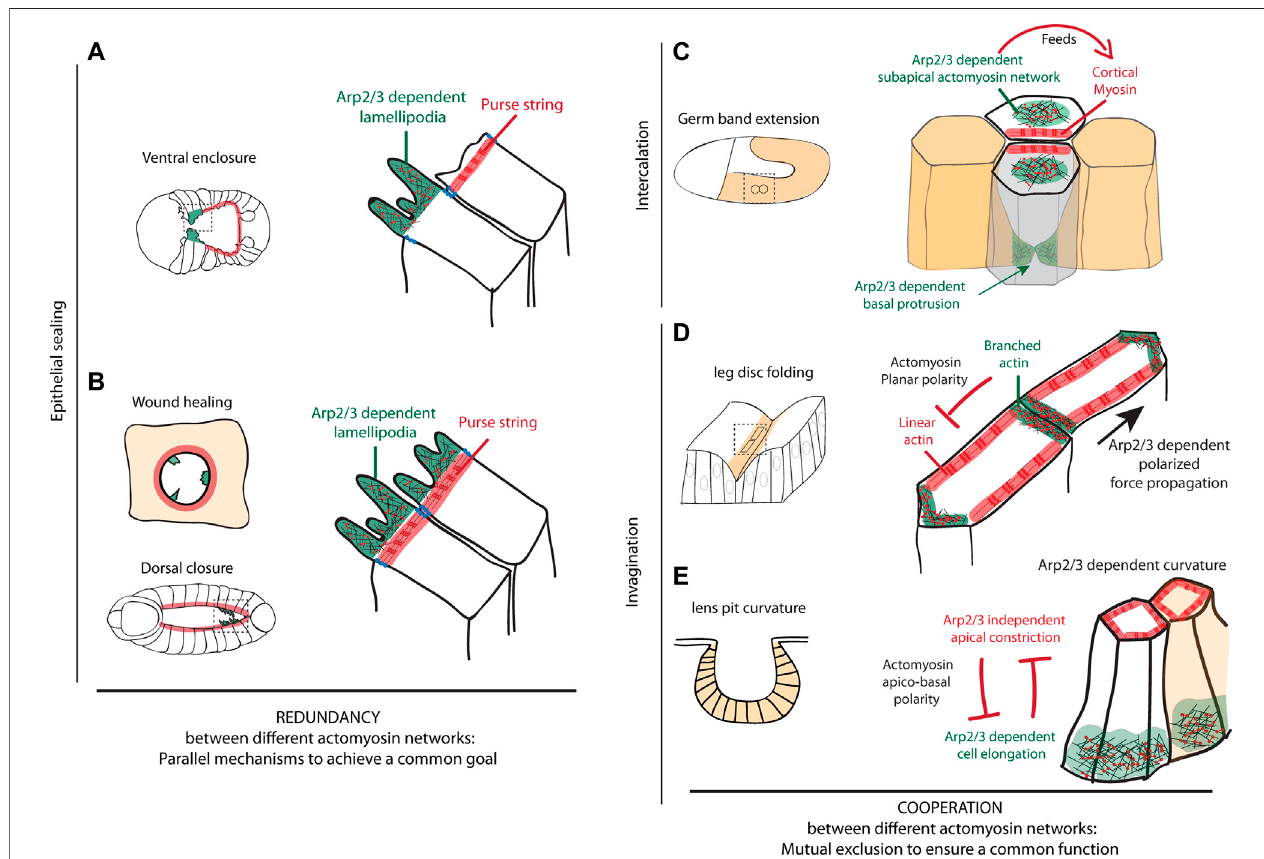
FIGURE 2 | Arp2/3 functions during morphogenetic events (A – B) Epithelial sealing mechanisms are schematized, including ventral enclosure in C. elegans (A) , epithelial wound healing and dorsal closure in Drosophila (B) . These schemes show that Arp2/3 plays an important role during epithelial sealing in the formation of lamellipodia. Theyfurtherhighlightthatbranchedandlinearactin networks actinparallel inthesedifferentmodel systemstoclose agapseparatingtwoepithelialsheets, thus showing a functional redundancy (C – E) Schemes of cell intercalation mechanism during germ band extension in Drosophila (C) and tissue invagination mechanisms in Drosophila leg disc and during lens pit formation in mouse (D – E) are presented. They summarize the different subcellular localizations of branched actin network Arp2/3-dependent during these remodeling events. These branched networks can either (C) form a subapical meshwork excluded from the cortex feeding the cortical accumulation of myosin, (D) be planar polarized and located preferentially in a subset of junctions while linear actin show a complementary localization favoring thepolarized transmissionofforcesacrossthetissueandensuringfoldrobustnessor (E) formabasalnetworkrequiredforcellelongationwhilebeingexcludedfromthe constricting apex and contribute to tissue curvature. These examples further show that branched and linear actin networks can cooperate, while showing a mutual exclusion spatially, to ensure a common function such as tissue elongation, polarized force propagation or tissue curvature.